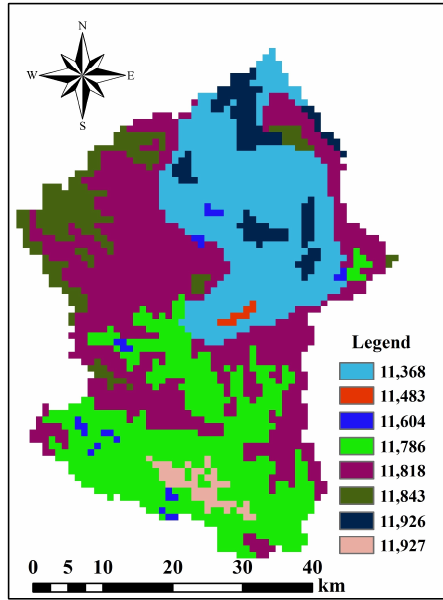
Figure 3. Soil distribution map of the Chengbi River basin.